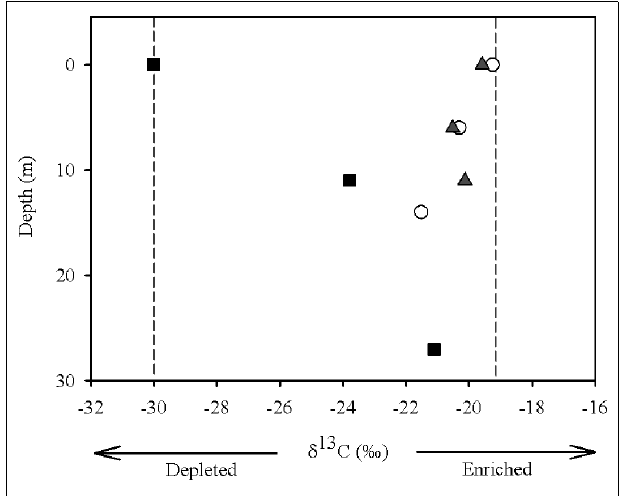
FIGURE 2 | Carbon isotope composition of the POM from the water sampled at different depths (surface, middle, and bottom) and in different zones (river = open circle, transition = gray triangle, and dam = black square) of the Manso Reservoir. Light gray lines represent the end members (allochthonous: δ 13 C − 19.26 ‰ and autochthonous: δ 13 C − 30.10 ‰ ).